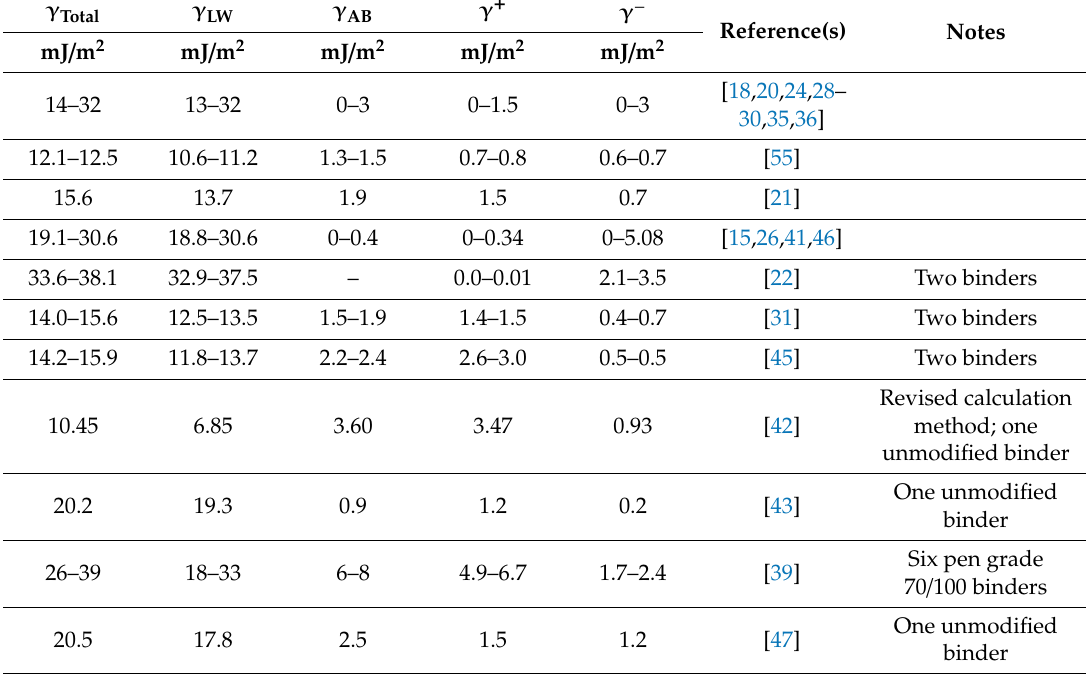
Table 2. Overview of typical values of surface energies for unmodified bituminous binders, using the Wilhelmy plate